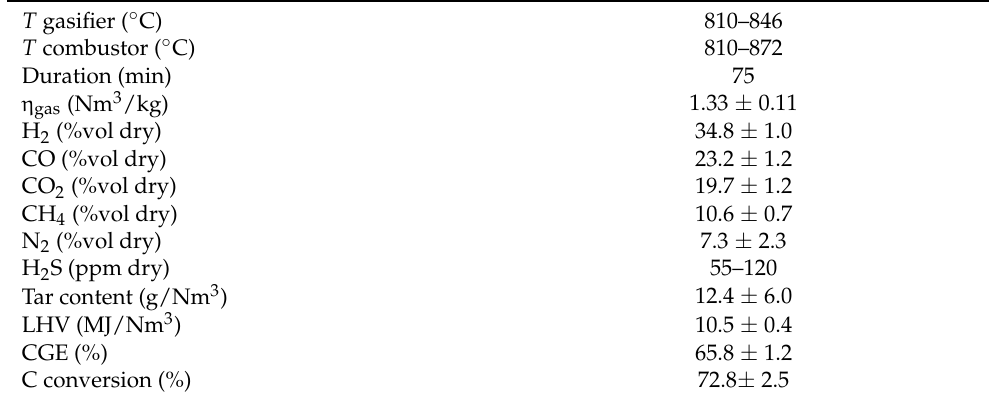
Table 4. Results of the gasification